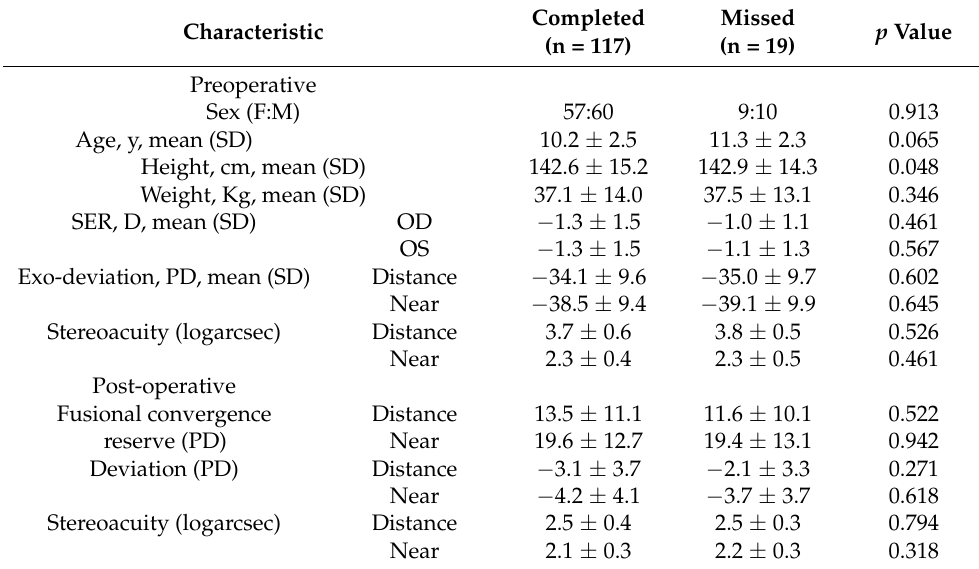
Table 2. The difference in demographic and baseline clinical characteristics between the IXT patients who missed and completed the 12-month follow-up